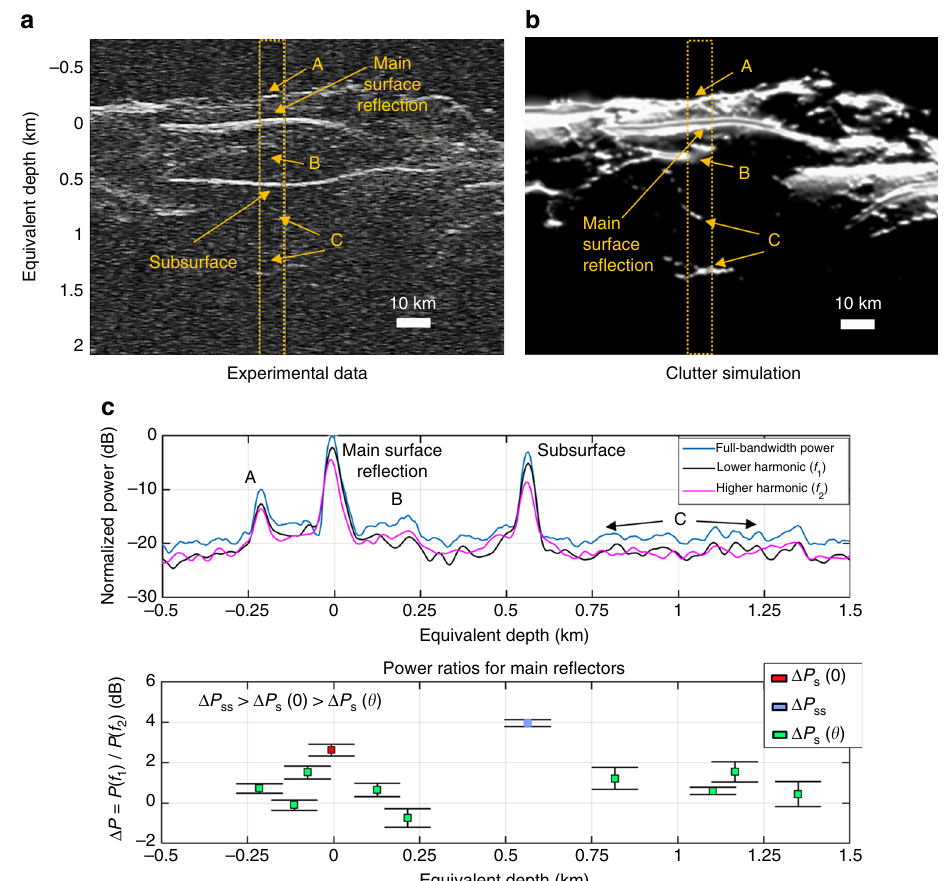
Fig. 9 Example of clutter and signal detection in the Deuteronilus Mensae region. Example of the bio-inspired model results for a portion of the SHARAD radargram 0716902. The radargram is acquired over Deuteronilus Mensae and contains both clutter and subsurface features. The disambiguation condition Δ P ss (0, z ) > Δ P s (0) ≥ Δ P s ( θ ) is veri fi ed allowing the discrimination of clutter to be accurately performed. a SHARAD radargram 0716902. The dashed orange box is the region under investigation. Off-nadir clutter re fl ections are marked with letters from A to C. b Clutter simulation con fi rming that the re fl ections marked as A, B, and C are generated by surface features only and that in the experimental data there is a legitimate subsurface re fl ection. c Echo traces (average over the investigated region) for the full and split bandwidth SHARAD signal (upper plot) and mean and standard deviation of power ratios for main re fl ectors (lower plot). The number of echo traces considered for deriving the statistics is equal to 700. The equivalent depth in the subsurface medium is computed from time delay assuming ε =